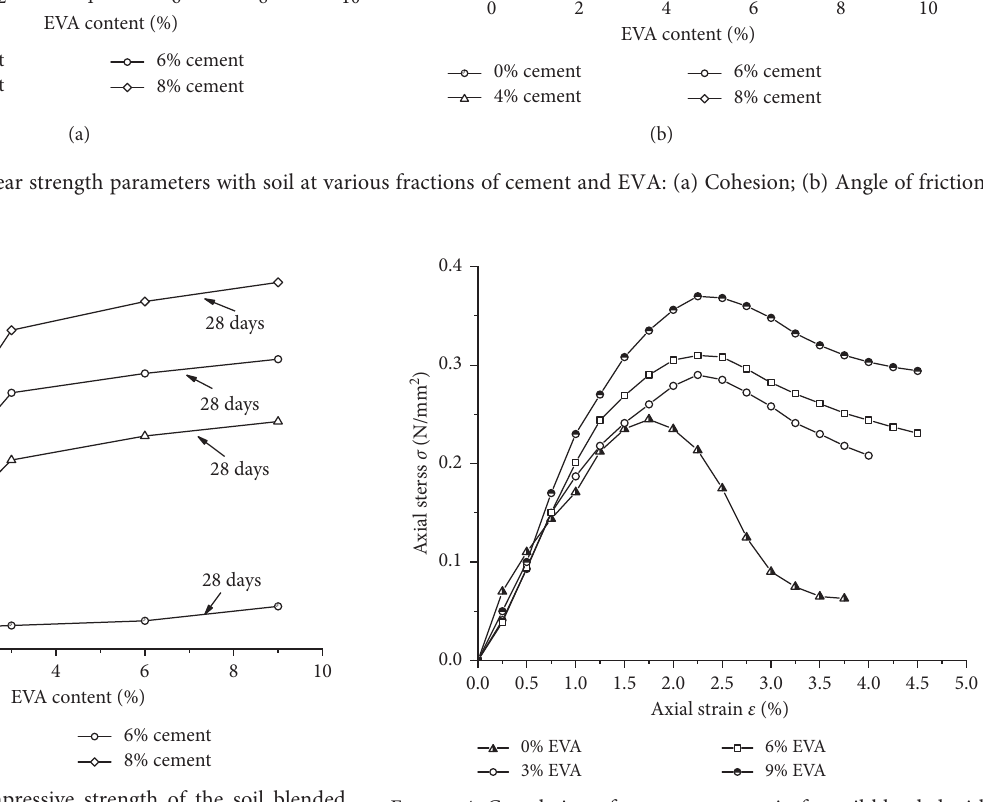
Figure 4: Correlation of stress versus strain for soil blended with EVA at various